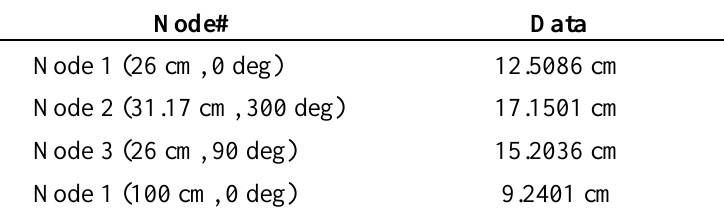
Table 3. Position difference between true value and estimation value using the simple mean.